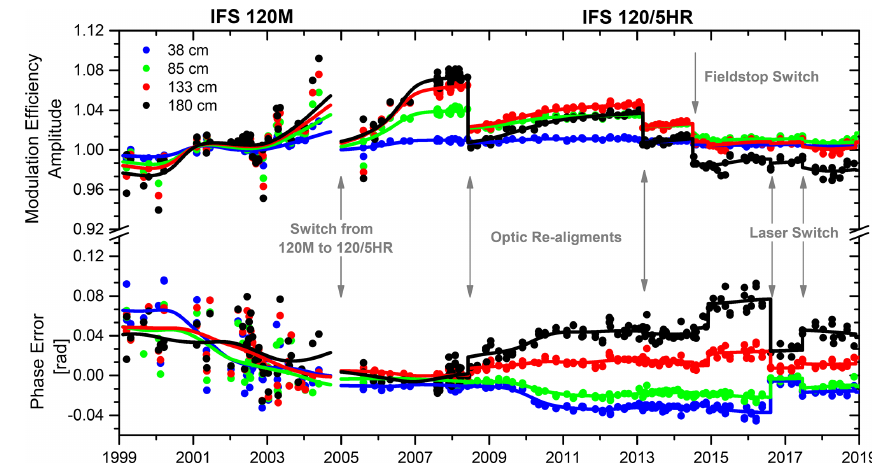
Figure 5. Time series of the modulation efficiency amplitude (MEA) and phase error (PE, in rad) at four OPDs (38, 85, 133, and 180cm) for NDACC filter 4 measurement settings (InSb detector) of the IZO FTIR spectrometers between 1999 and 2018. Data points represent individual low-pressure N 2 O cell measurements, and solid lines show smoothed MEA and PE curves. The solid grey arrows indicate punctual interventions on the instruments: switch from the IFS 120M to the IFS 120/5HR system in 2005, optic re-alignments in June 2008 and February 2013, change of field stop in October 2014, and internal reference laser replacements in August 2016 and June